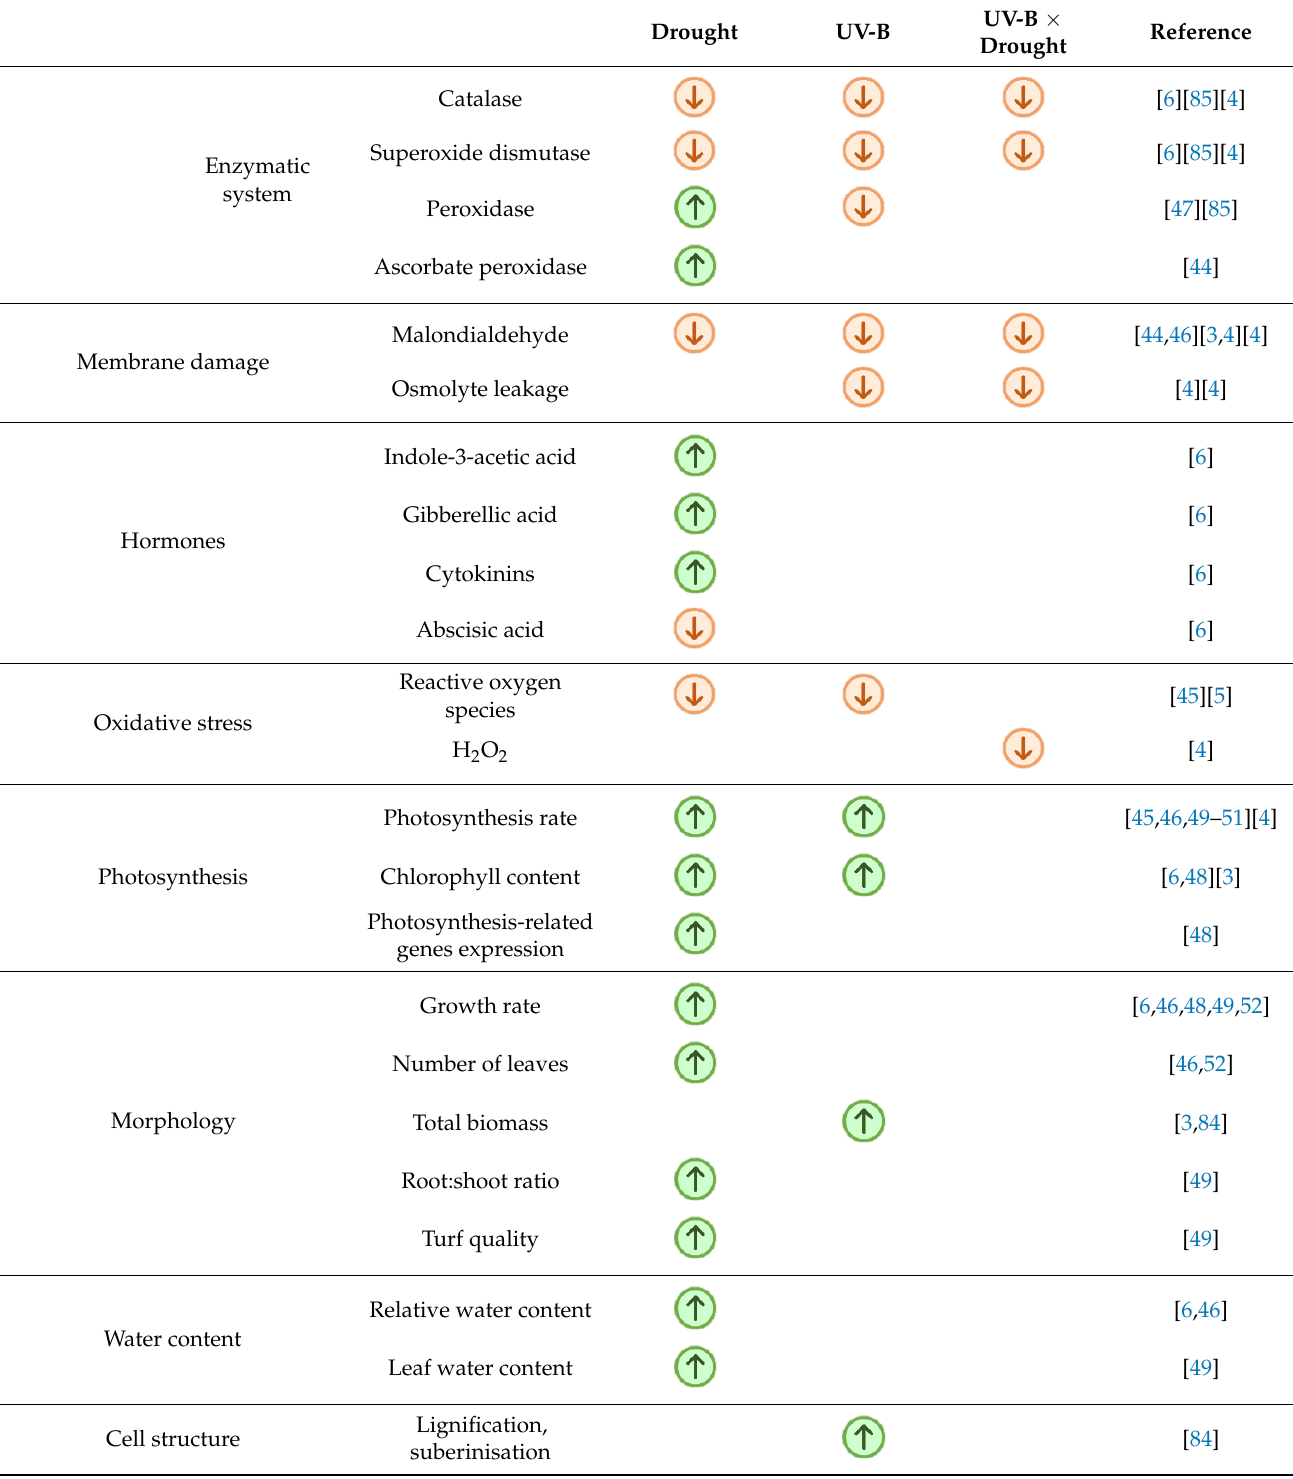
Table 3. Effects of silicon supplementation on the measured parameters in the presence of UV-B, drought and their combination as revised from the literature. Arrows indicate increases ( ↑ ) or de- creases ( ↓ ) of each parameter under UV-B, drought, or combined stress conditions (UV-B × drought) in silicon treated plants.